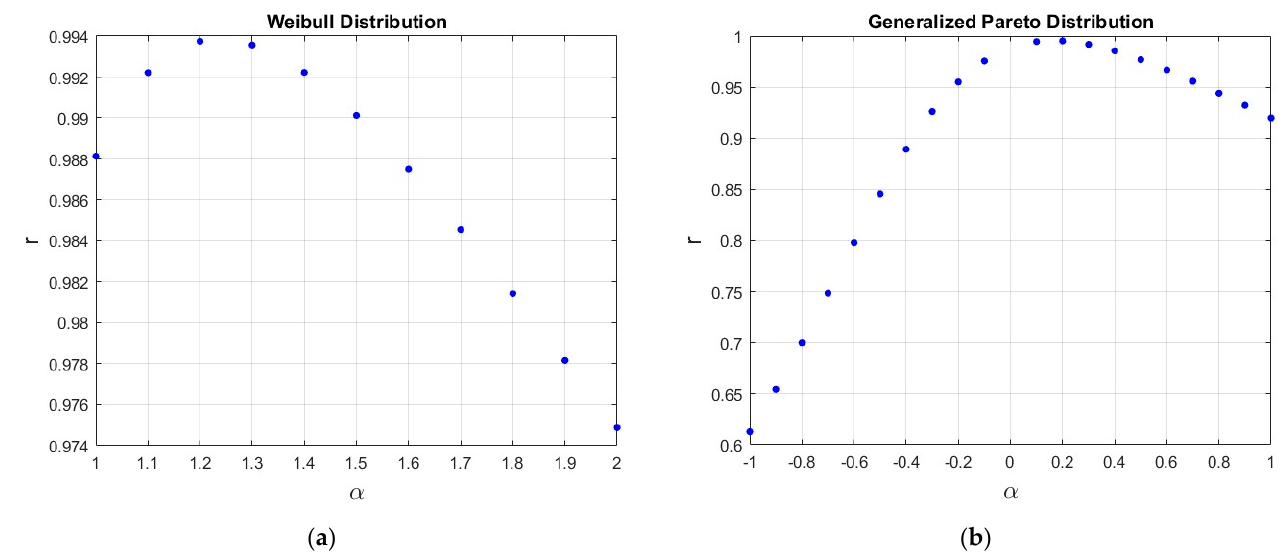
Figure 3. Correlation coefficient (r) values for different shape parameter values ( α ) for the selected candidate distribution functions. The maximum value of r gives the value of α of the candidate function that best fits the wave dataset: ( a ) Weibull distribution; ( b ) Generalized Pareto Distribution (GPD). The ordered 113 peak storms above the 2.5 m threshold are extracted, and their storm, the reduced variates are calculated for each distribution. Table 2 shows sample G, W, E, and U correspond to the reduced variates for the Log-normal, Gumbel,